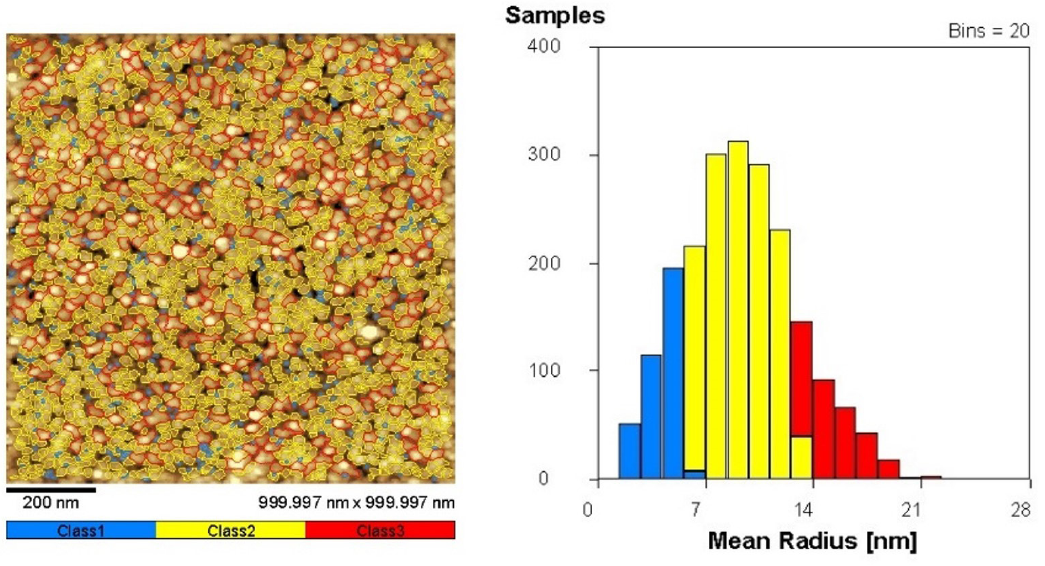
Figure 4. AFM on (1 × 1) µm scan of the BL (-50 V) and the mean grain radius